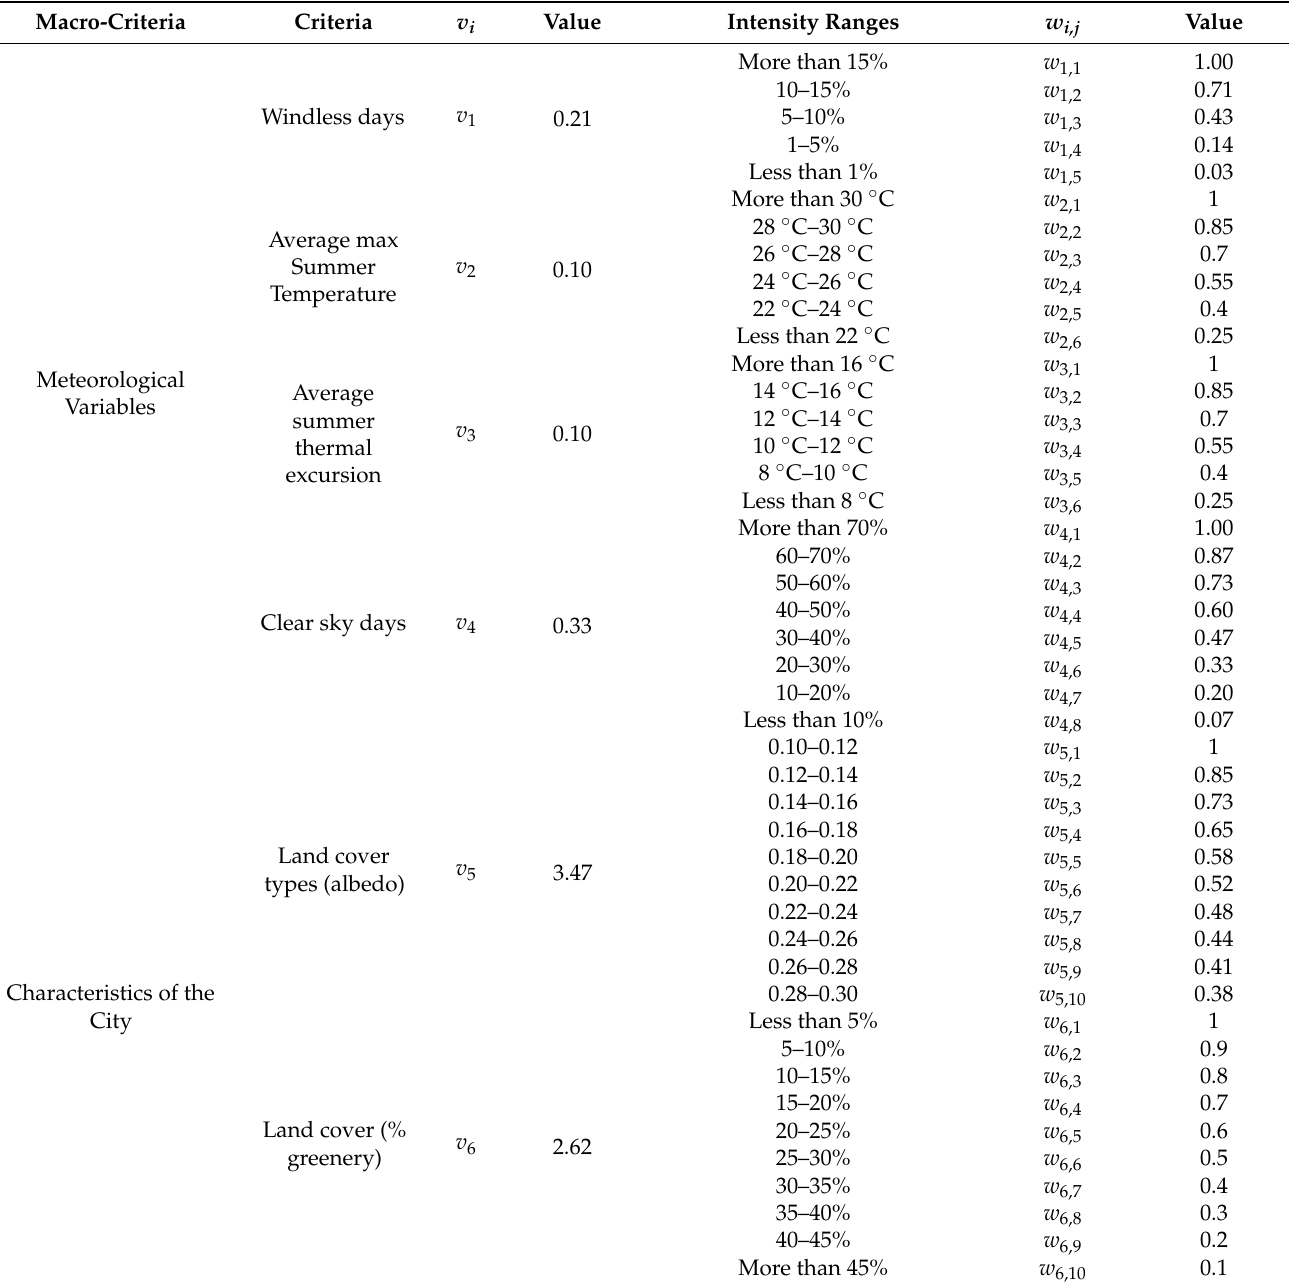
Table 1. Tabulated weights and the association of weights w ij with the intensity